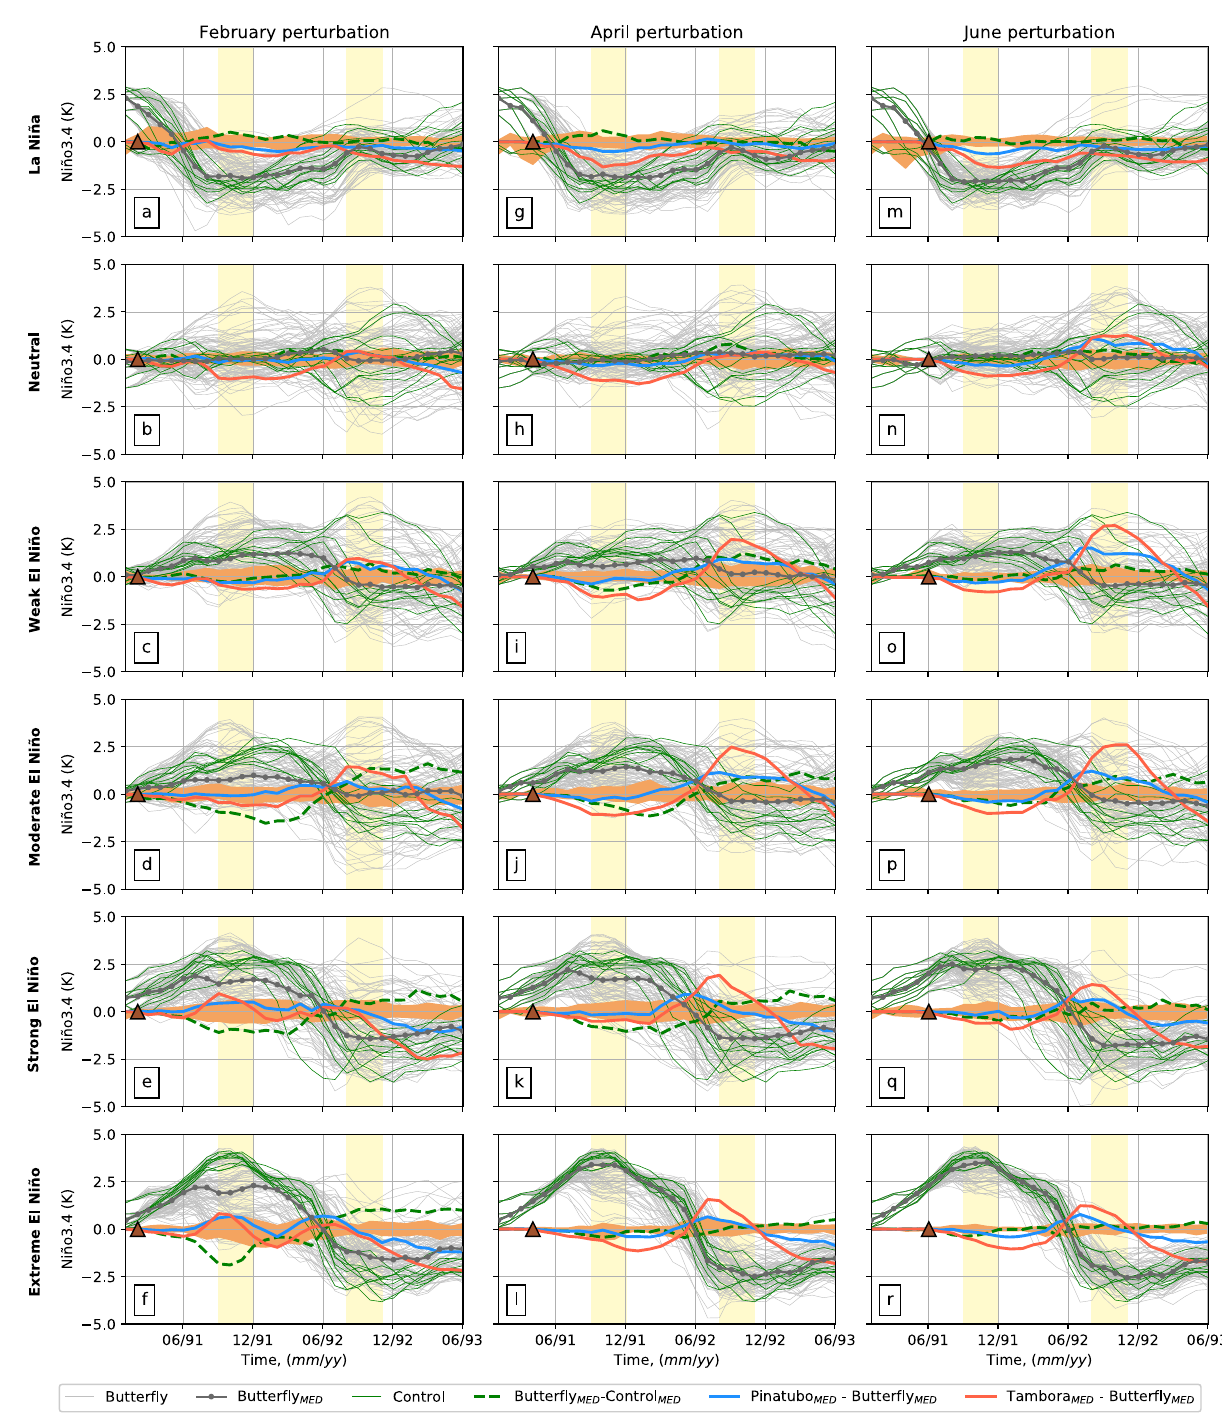
Fig. 1 SST responses to Butter fl y and volcanic perturbations. Control and perturbed Niño3.4 (K) and their responses to February ( a – f ), April ( g – l ), or June ( m – r ) Butter fl y and volcanic perturbations. Eruption times are marked by brown triangles. Each row represents an individual control ENSO onset group: La Niña ( a, g, m ), Neutral ( b, h, n ), weak El Niño ( c, i, o ), moderate El Niño ( d, j, p ), strong El Niño ( e, k, q ), and extreme El Niño ( f, l, r ) (see Experimental setup for ENSO event de fi nitions). Spaghetti curves represent individual Niño3.4 trajectories from the control ensemble (green) and Butter fl y grand-ensemble (gray). The median of each Butter fl y grand-ensemble (Butter fl y MED ) is shown as a thick gray curve with dots. Dashed green curve represents the stochastic response calculated as the Butter fl y MED minus the control ensemble median (Control MED , Supplementary Fig. 1); this is the correction that would be needed to remove the post-initialization stochastic selection bias present in the control ensemble. The deterministic response to the Pinatubo-size (blue) and Tambora-size (red) volcanic forcings is calculated as the corresponding volcanic grand-ensemble median (Pinatubo MED or Tambora MED , Supplementary Fig. 1) minus Butter fl y MED . Orange-shaded two-tailed bootstrap con fi dence intervals calculated from the Butter fl y grand- ensemble medians help to detect the statistical signi fi cance of the deterministic signal of the eruption median relative to the Butter fl y median at 0.05 signi fi cance level. Yellow-shaded vertical bands indicate the seasons OND 1991 and SON 1992 used to summarize ENSO responses in Fig.